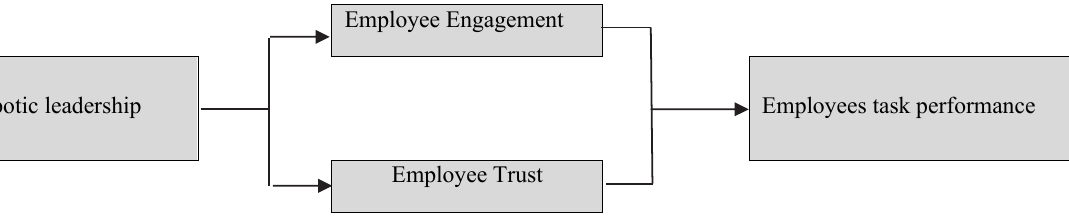
Fig. 1. Graphical representation of the model of the